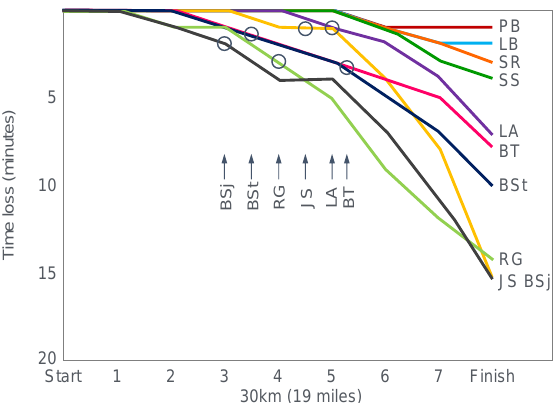
Figure 7. The time differences at 8 checkpoints when the same athletes ran two 30 km races after high- and mixed-carbohydrate diets. All athletes ran slower after the mixed-carbohydrate diet. Arrows indicate the point in the race at which athletes who started the race with low muscle glycogen concentrations, because they had eaten the mixed-carbohydrate diet, were predicted to have reached ‘limiting’ low muscle glycogen concentrations. Adapted with permission from ref. [19]. Copy-right 1971 American Physiological Society.